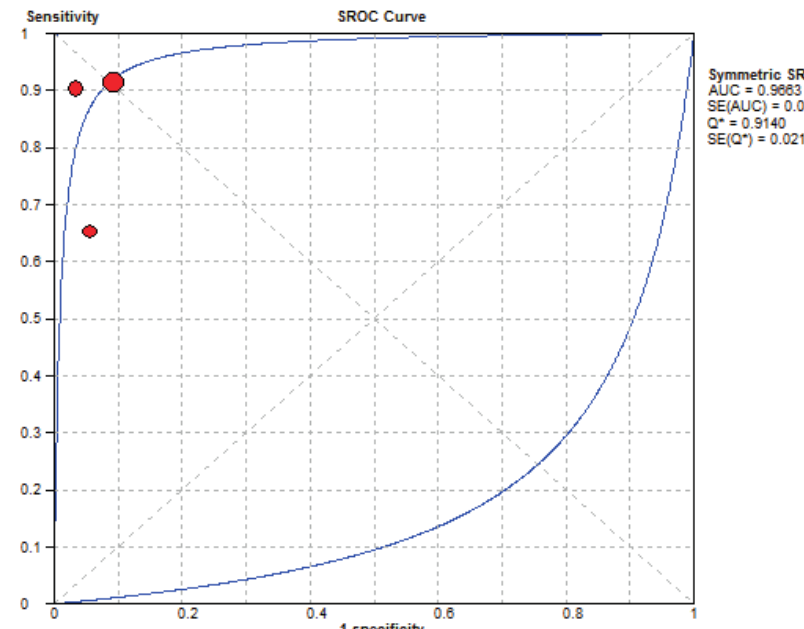
Figure 4 - SROC Curve of